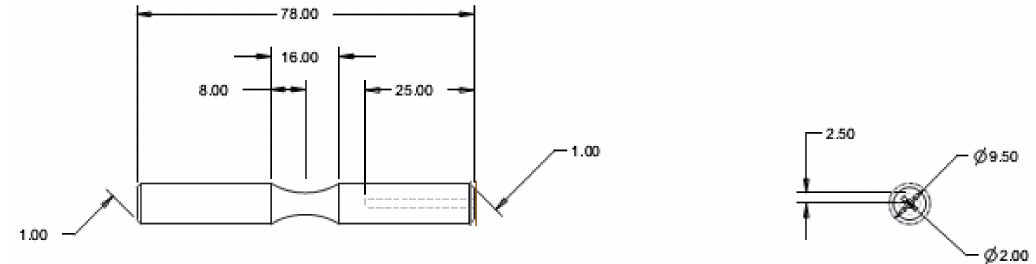
Figure 1. Geometry of fatigue samples; dimensions are expressed in